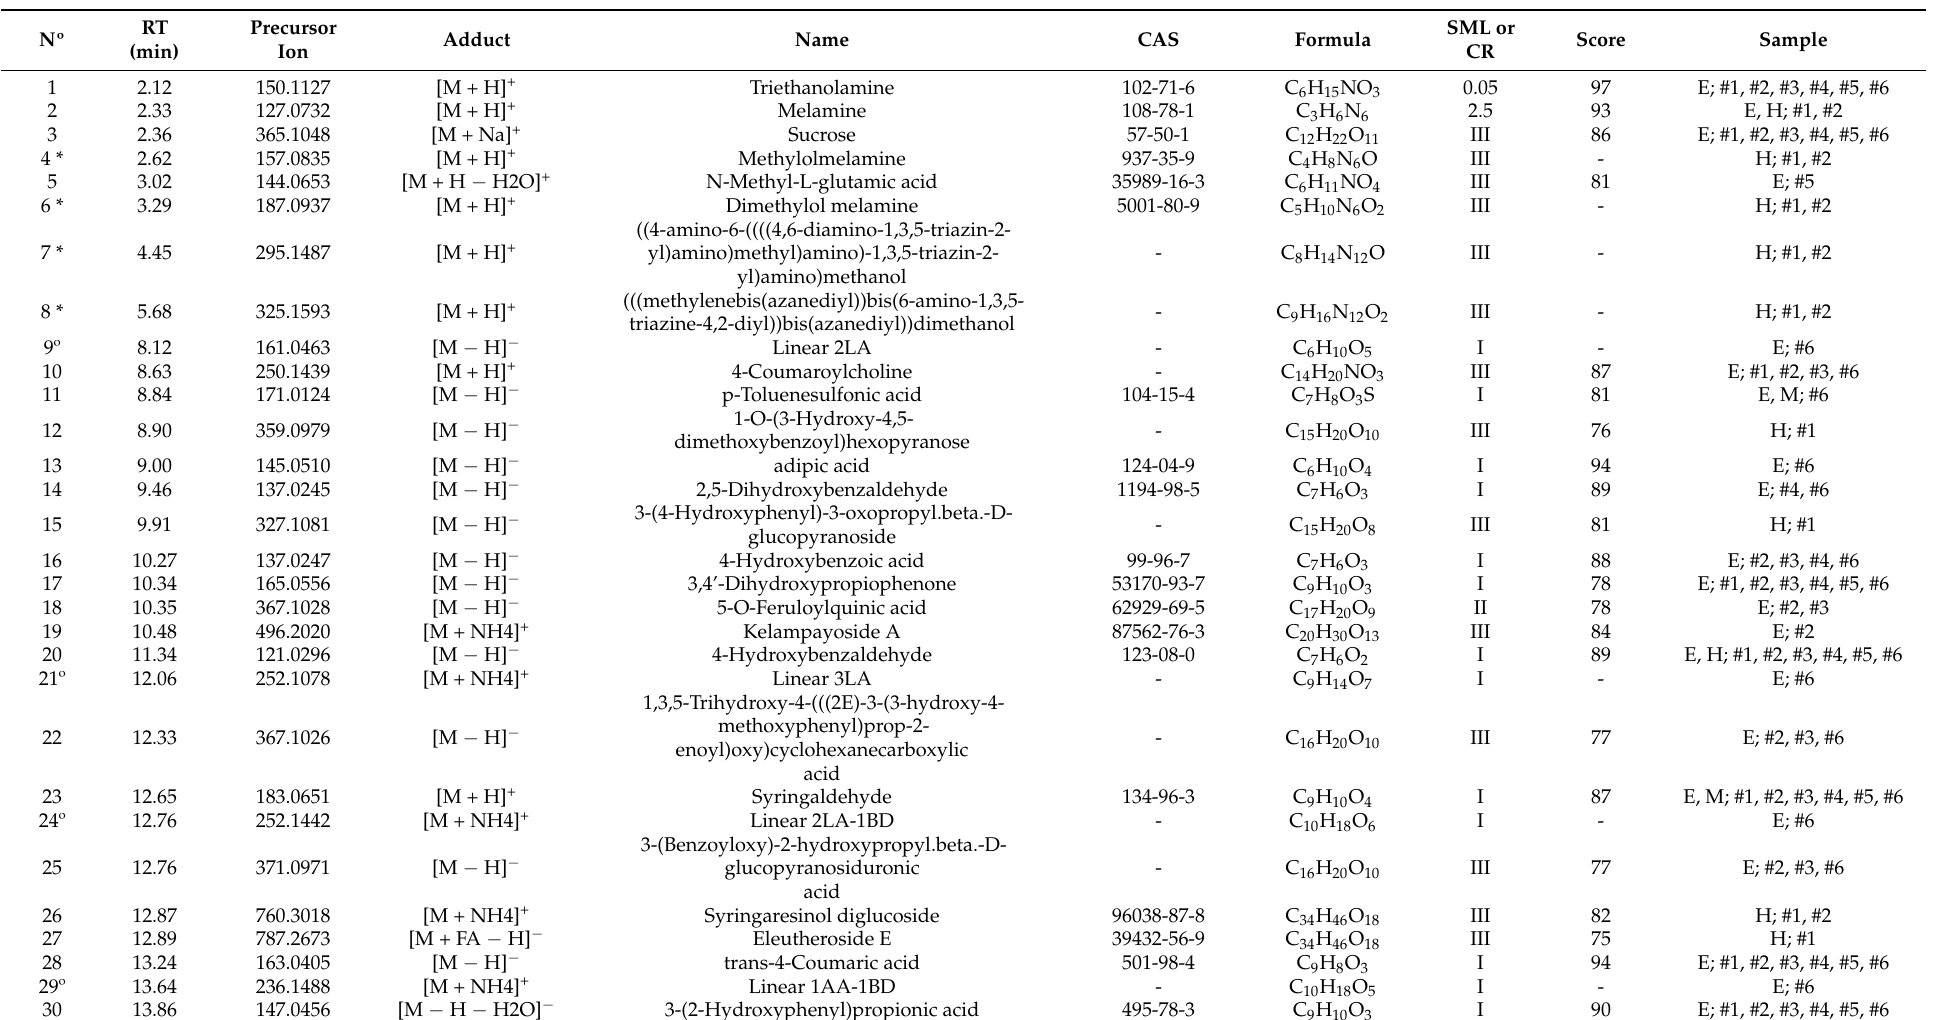
Table 2. Non-volatile substances tentatively identified in plant fiber/plastic